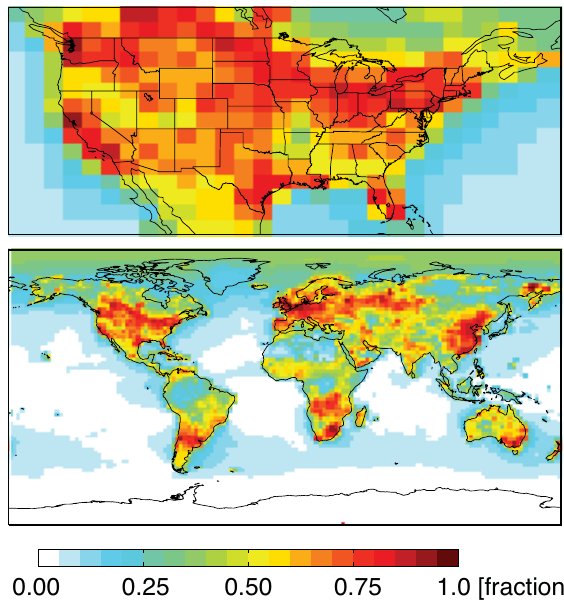
Fig. 3. Fraction of peroxy radical species reacting with NO, β , av- eraged for the month of August 2000 at the surface (model level 1) for the United States and globally.